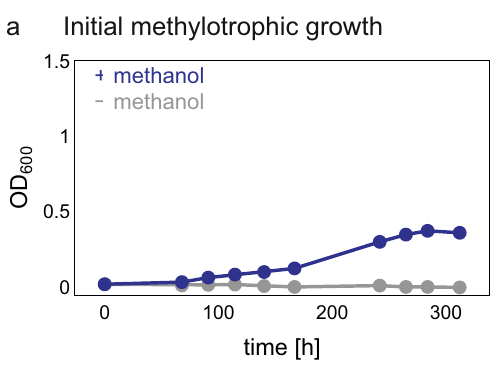
Entner – Doudoroff pathway as well as methanol dehydrogenase were upregulated, while enzymes of branch point reactions away from the RuMP cycle, pyruvate metabolism and the TCA cycle were down- regulated (Fig. 5). We further contextualized the proteome data by that methanol dehydrogenase increased in abundance from 16% of the quanti fi ableproteomeintheancestralstrainto40%inMEcoli_ref_1.This was substantiated by sodium dodecyl sulfate – polyacrylamide gel elec- trophoresis (SDS-PAGE) (Supplementary Fig. 5).